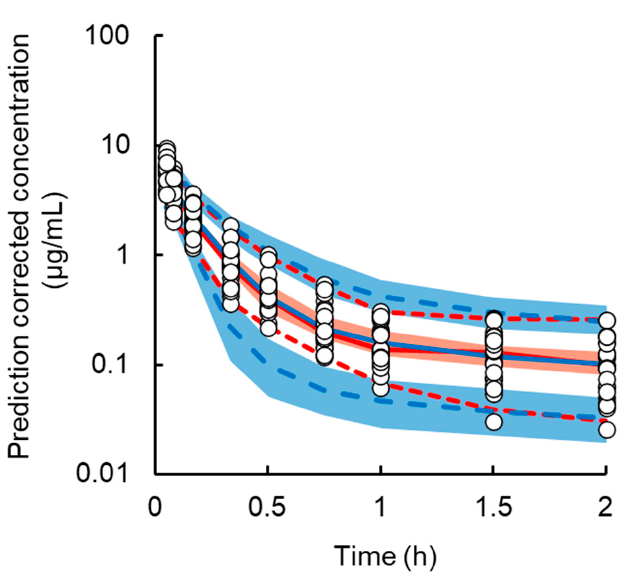
Figure 4. Prediction-corrected visual predictive check (pcVPC) plot for the final pharmacokinetic model of oxaliplatin (L-OHP) in normal, mild, and severe renal dysfunction model rats. The open circles represent individual observations. The red solid line represents the median and dashed lines represent the 5th and 95th percentiles of the observations, respectively. The blue solid line represents the median and dashed lines represent the 5th and 95th percentiles of the predictions, respectively. The shaded red area represents the 95% confidence interval of the median and the blue areas represent the 2.5th and 97.5th percentiles of the predictions, respectively.